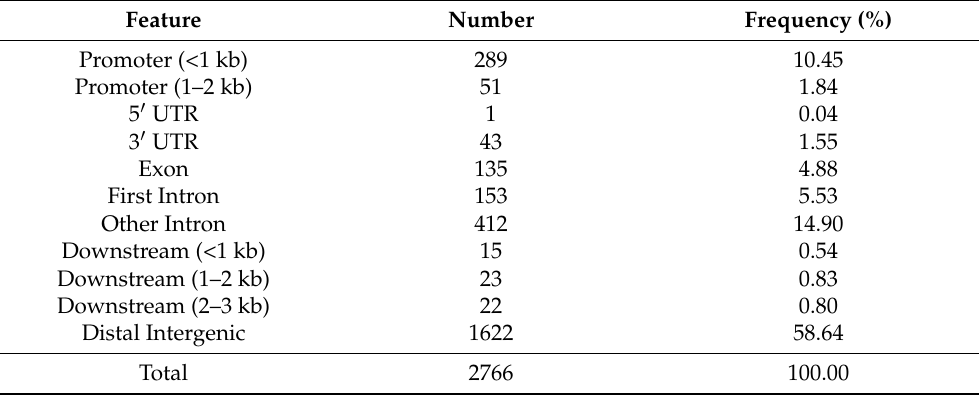
Table 4. Annotation of differentially accessible regions (DARs) for weaning.